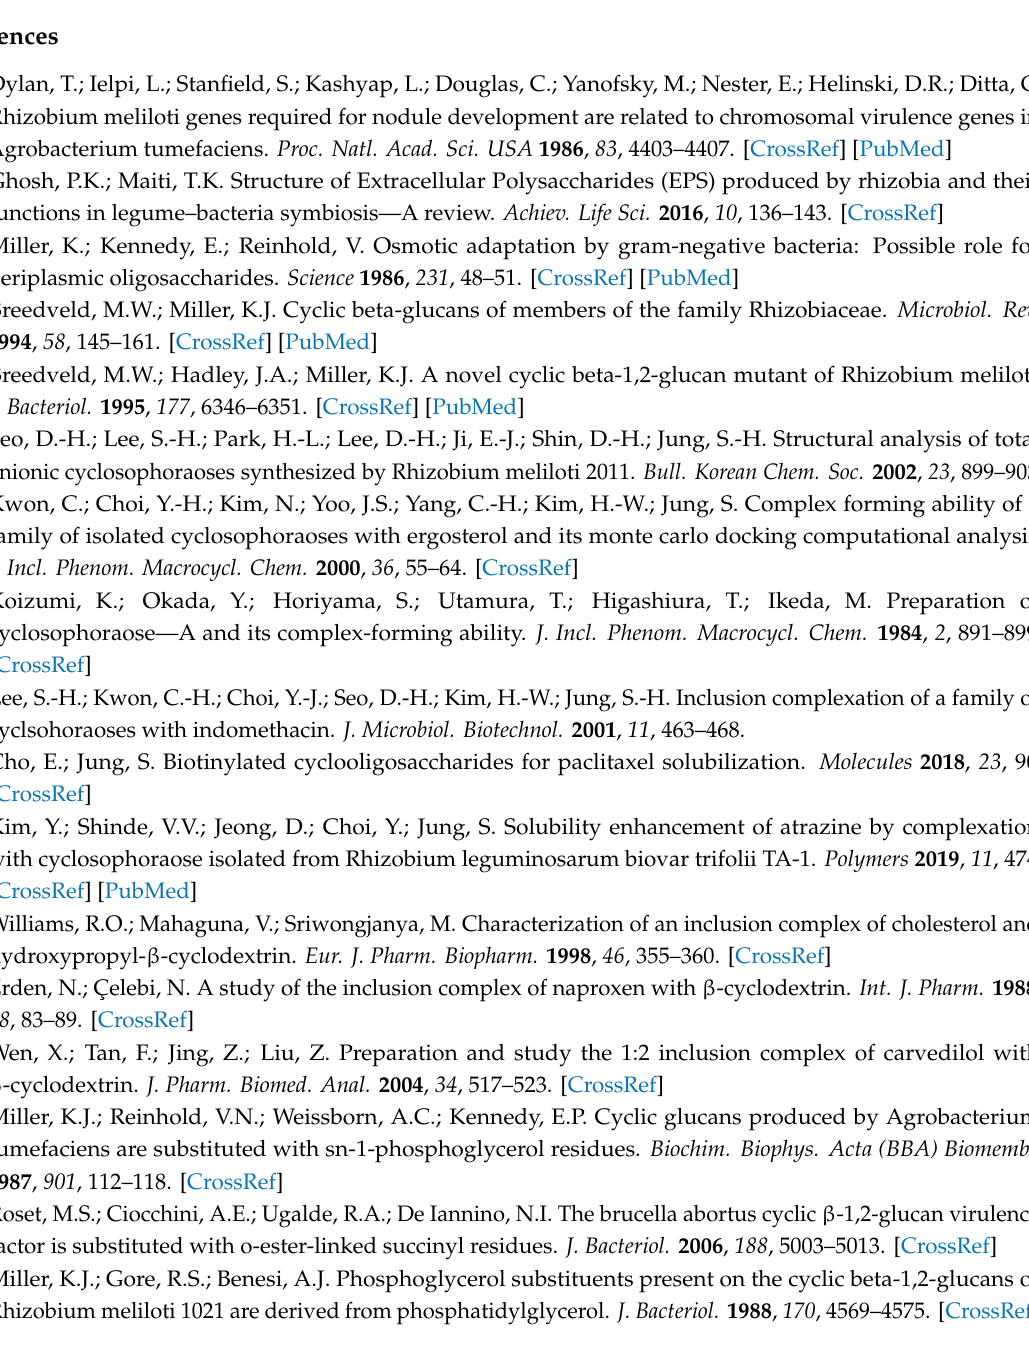
Figure S1: 1 H NMR spectra of (a) F2, (b) F3 and (c) F4 fraction, Figure S2: 13 C NMR spectra of (a) F2, (b) F3 and (c) F4 fraction, Figure S3: 31 P NMR spectra of (a) F2, (b) F3 and (c) F4 fraction, Figure S4: 1 H- 13 C heteronuclear single quantum coherence (HSQC) NMR spectra of (a) F2, (b) F3 and (c) F4